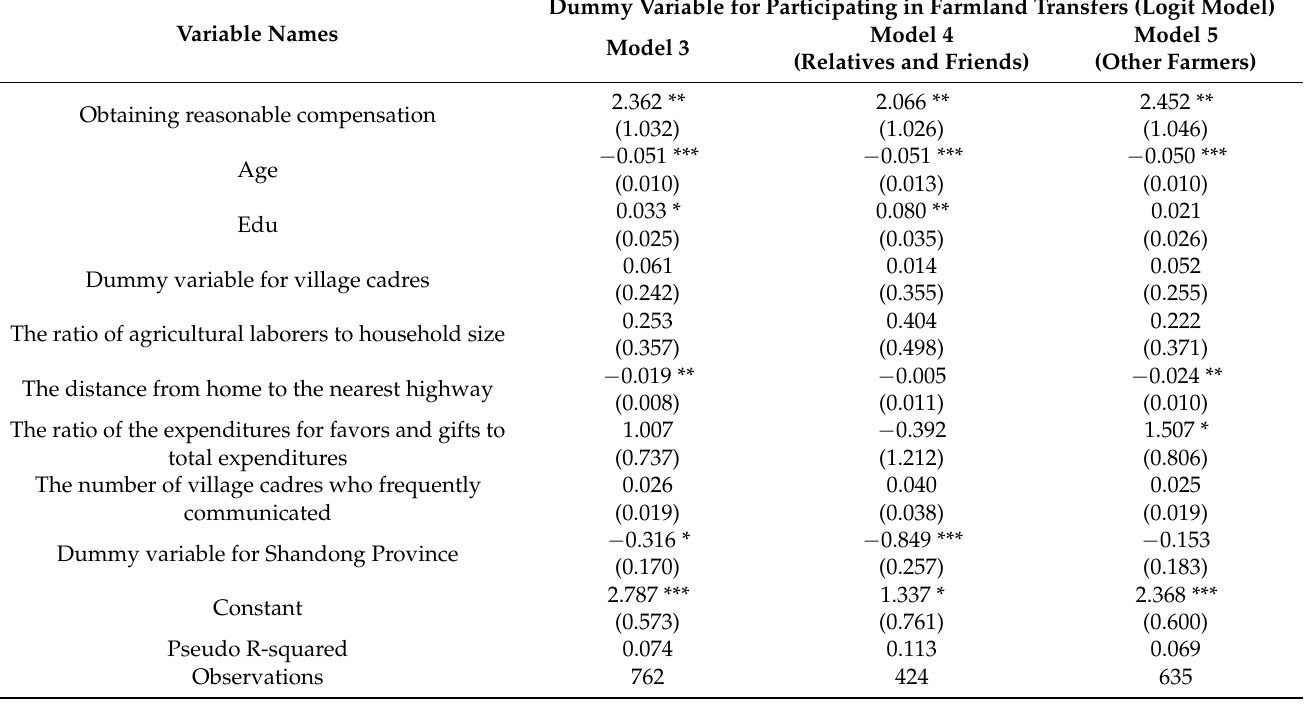
Table 4. Estimation results of the impact of obtaining reasonable compensation on farmland